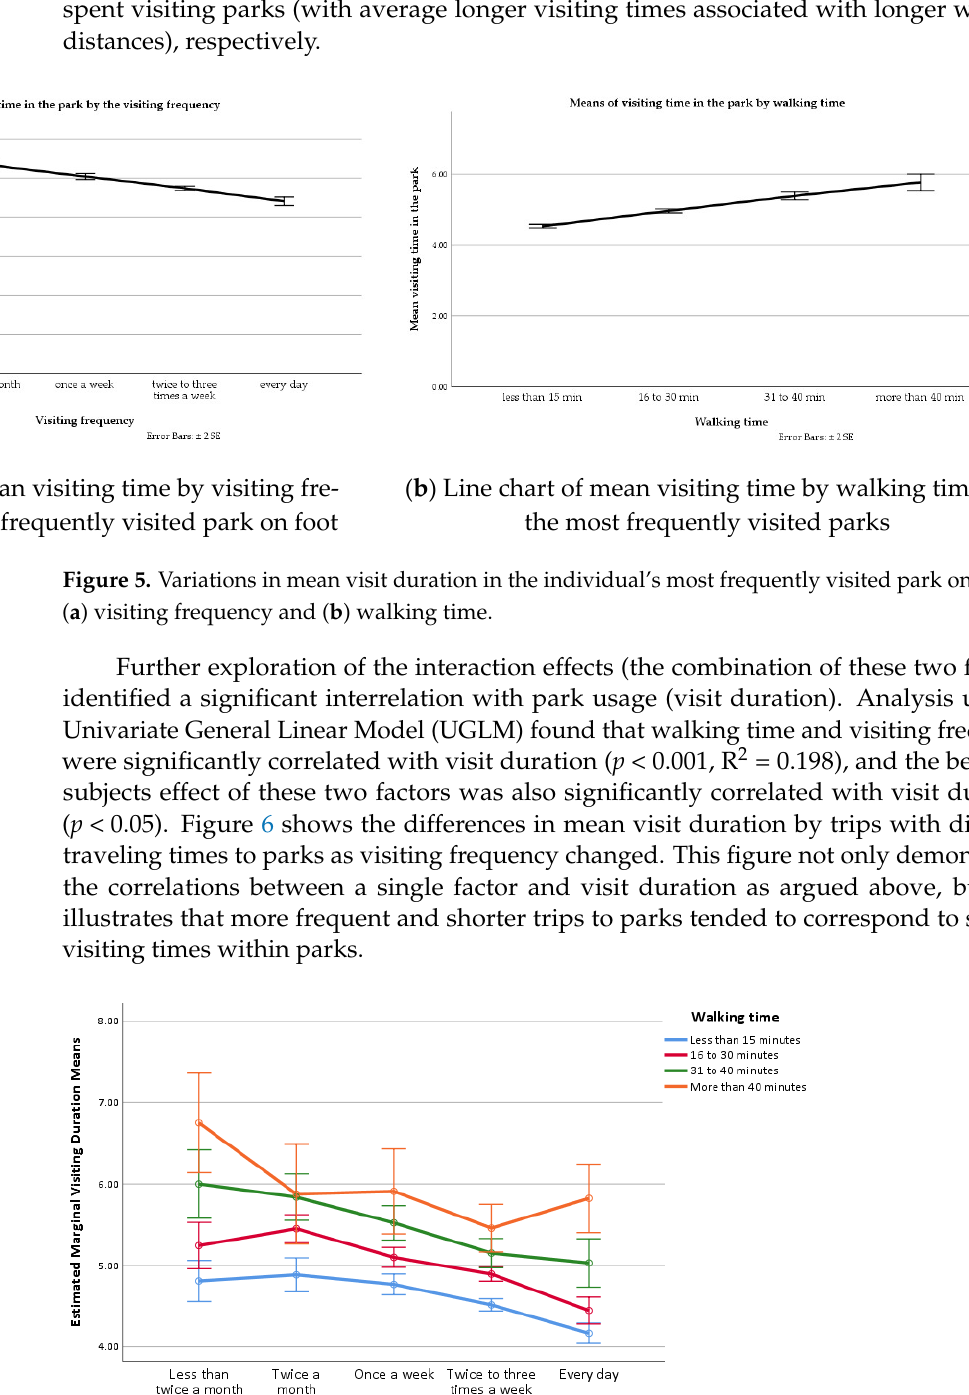
Table 5. Correlating significance values of reasons for and barriers to visiting parks. Reasons for Visiting Parks (N = 2263) Visitor Groups Walking/Ex- ercise